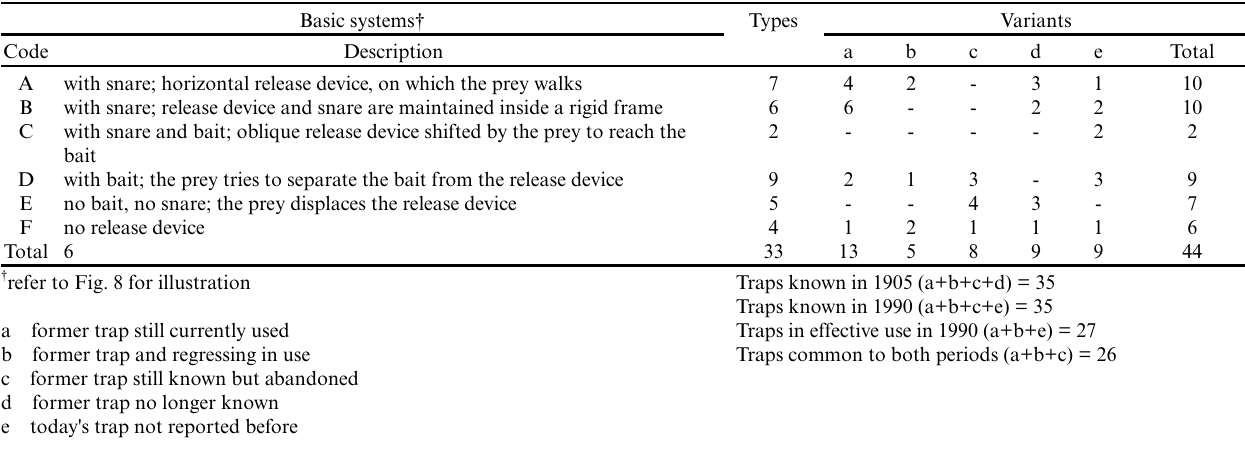
Table 1 . Knowledge and use resilience of Fang traps